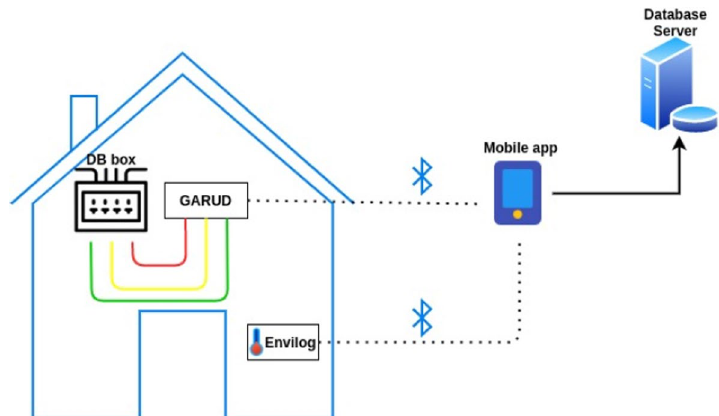
Fig. 1 Schematic for the location of loggers and the acquisition system